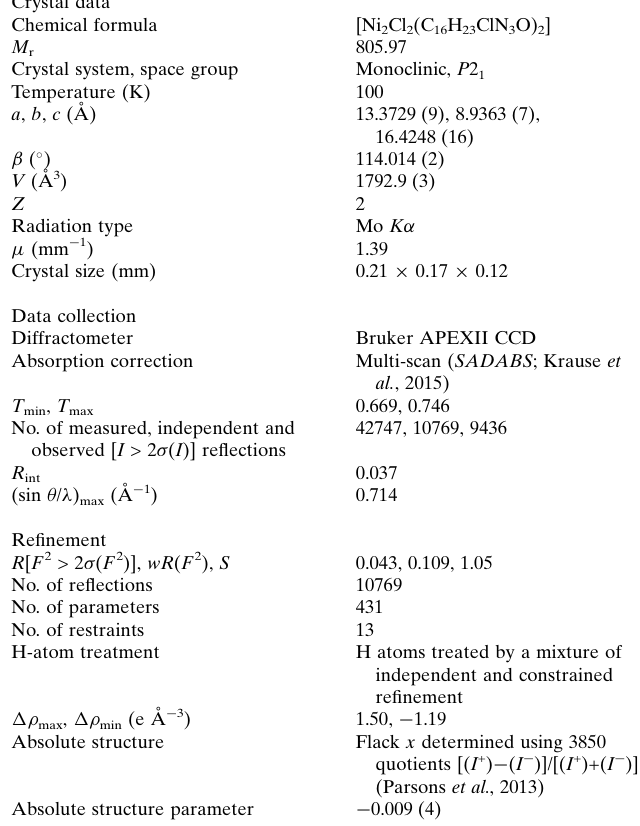
Table 2 Experimental details. Crystal data Chemical